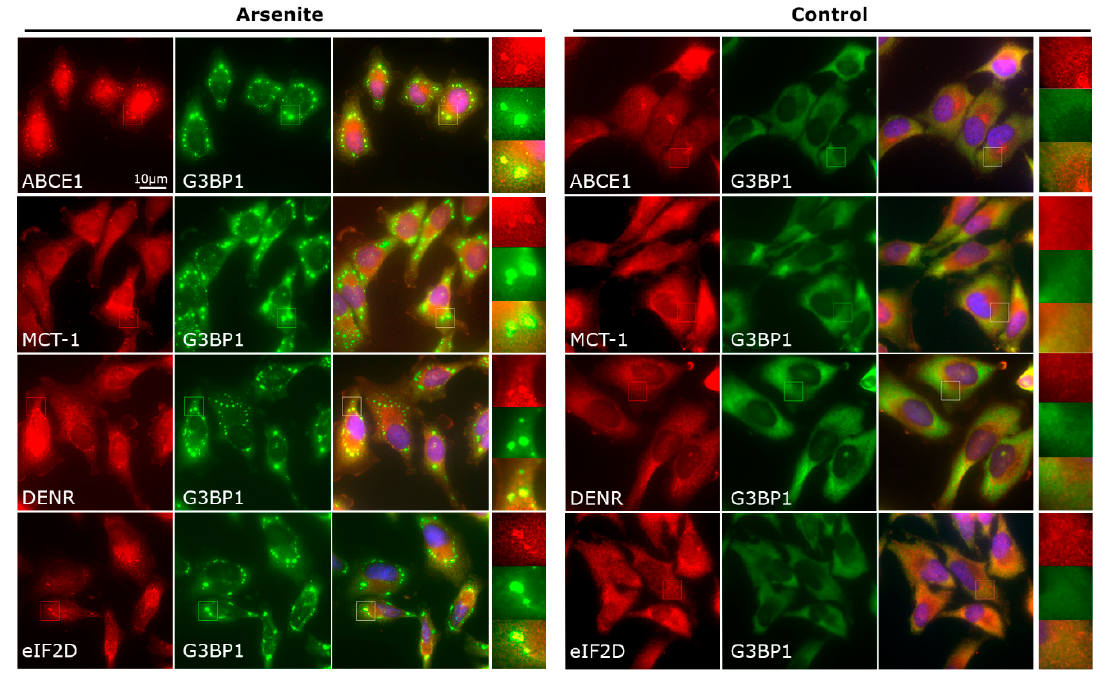
Figure 3. Ribosome recycling factors are recruited to arsenite-induced SGs. HeLa cells were treated with 250 µ M sodium arsenite for 1 h (left panel), followed by fixation and immunostaining for the protein of interest along with an SG marker G3BP1. Immunostaining of non-treated cells is presented in the right panel. A few representative cells are shown; boxes indicate magnified areas. All large images are of the same magnification (scale bar: 10 μ m).